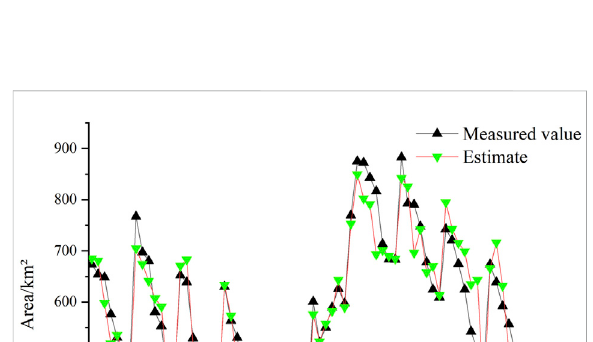
FIGURE 9 Schematicdiagram of in fl uencing factors of monthly average wind speed, monthly precipitation, and average temperature of the lake.